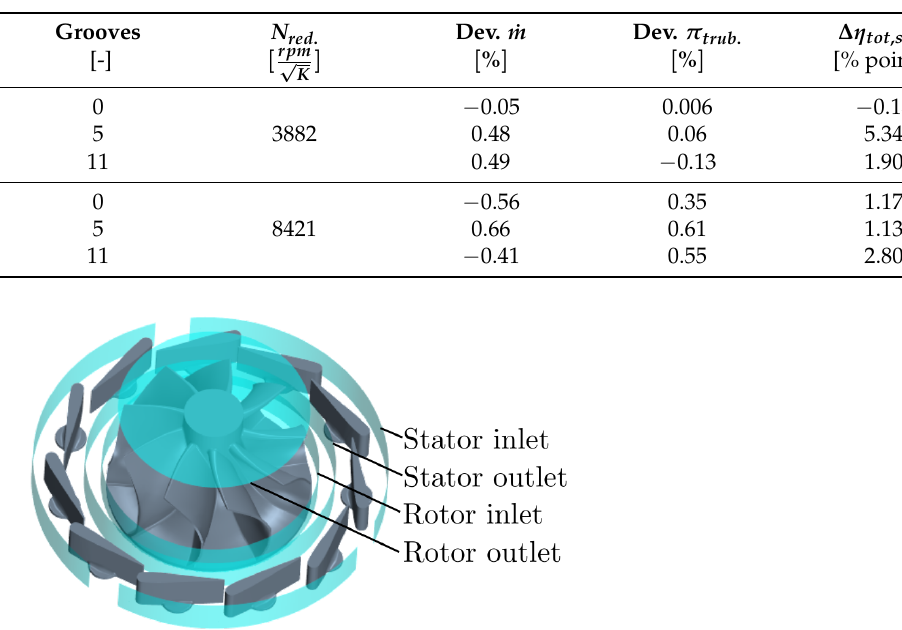
Table 2. Differences in the performance parameters of the case at higher PR when using 1 ◦ and 2 ◦ to define the time step.